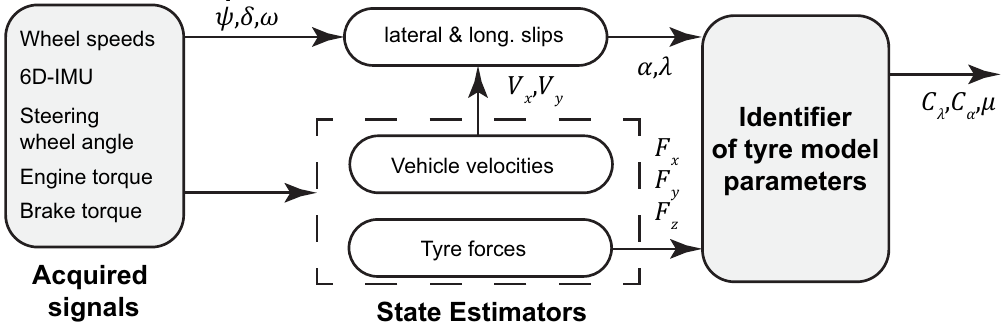
Figure 16. Estimation structure proposed by Choi et al. [99]. Figure adapted by the authors from